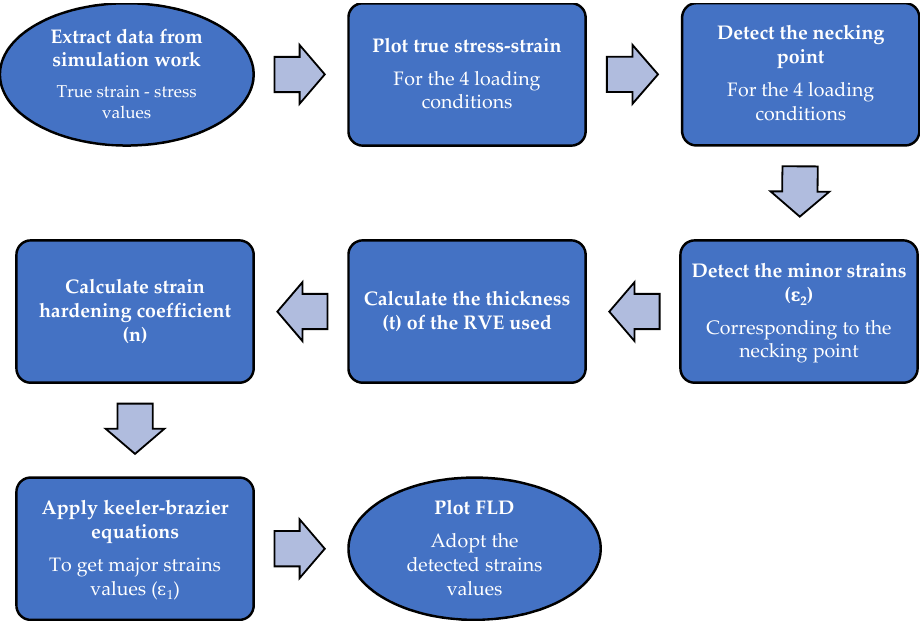
Figure A2. Process chart of plotting FLD via Keeler–Brazier (K-B) approach.